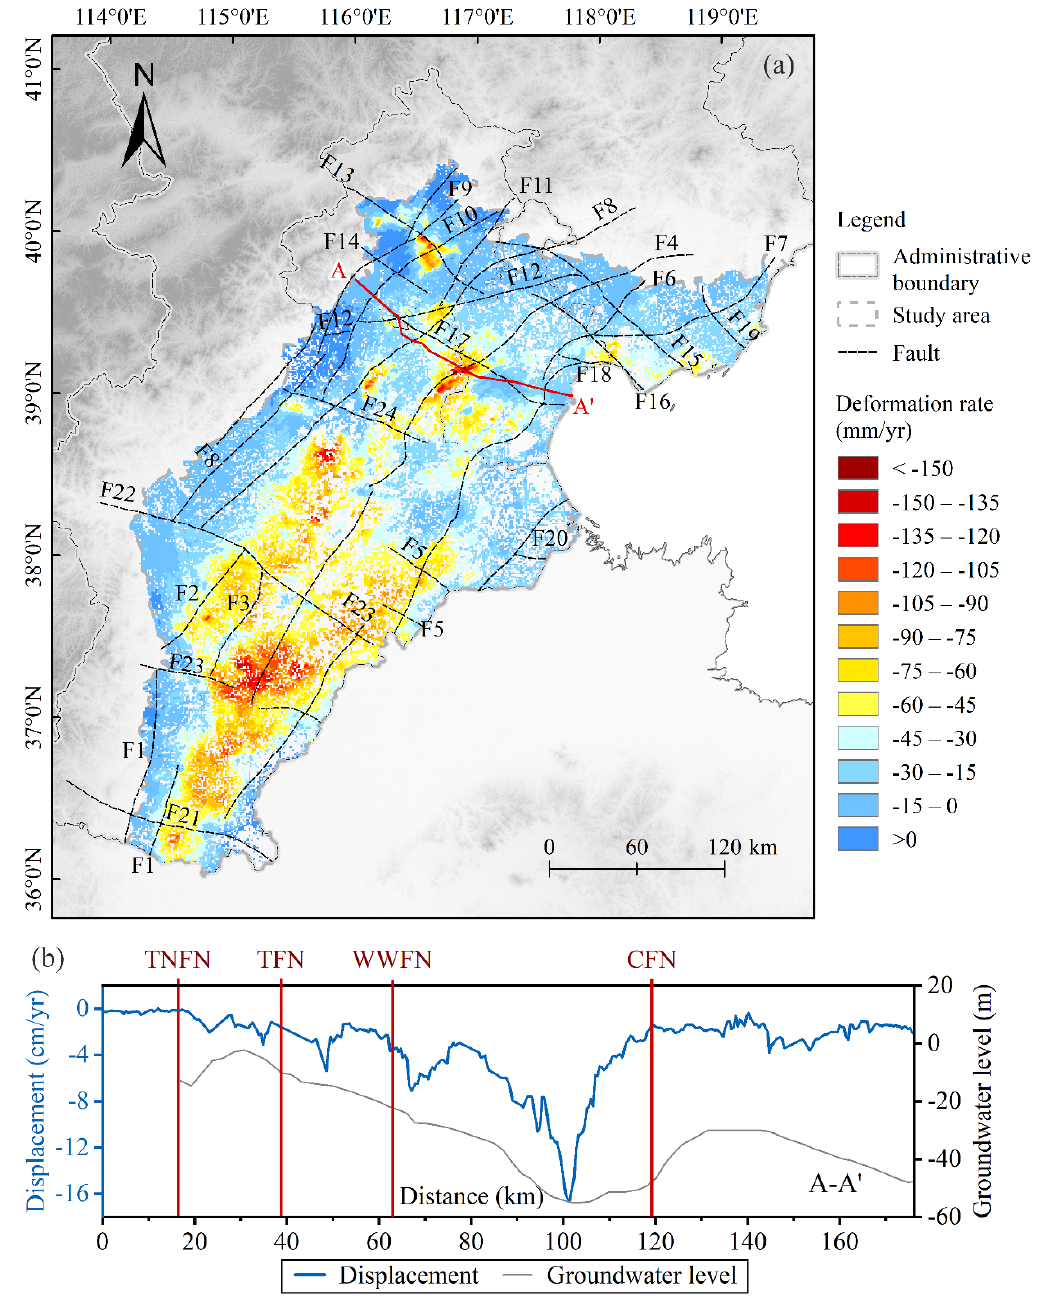
Figure 13. ( a ) Overlap of main active faults (revised after [41]) atop InSAR displacement rates and ( b ) a profile of the InSAR results: the locations of faults are indicated with red columns. TNFN, TFN, WWFN, and CNF are the abbreviations for Tongxian–Nanyuan fault zone, eastern Taihang fault zone, Wuqing–Wenan fault zone, and Cangdong fault zone, respectively. Table 4. Information on fault zones.